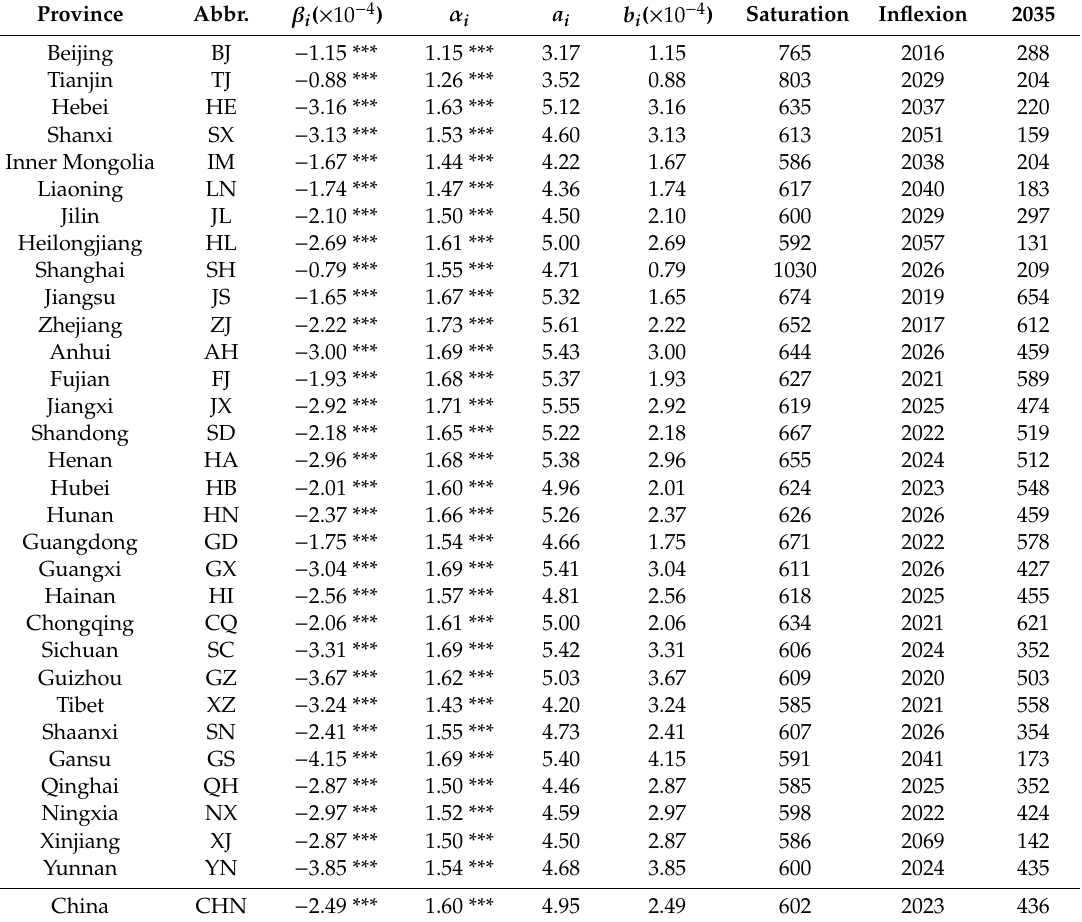
Table 4. Provincial projections of saturation level and vehicle ownership per 1000 people in 2035.